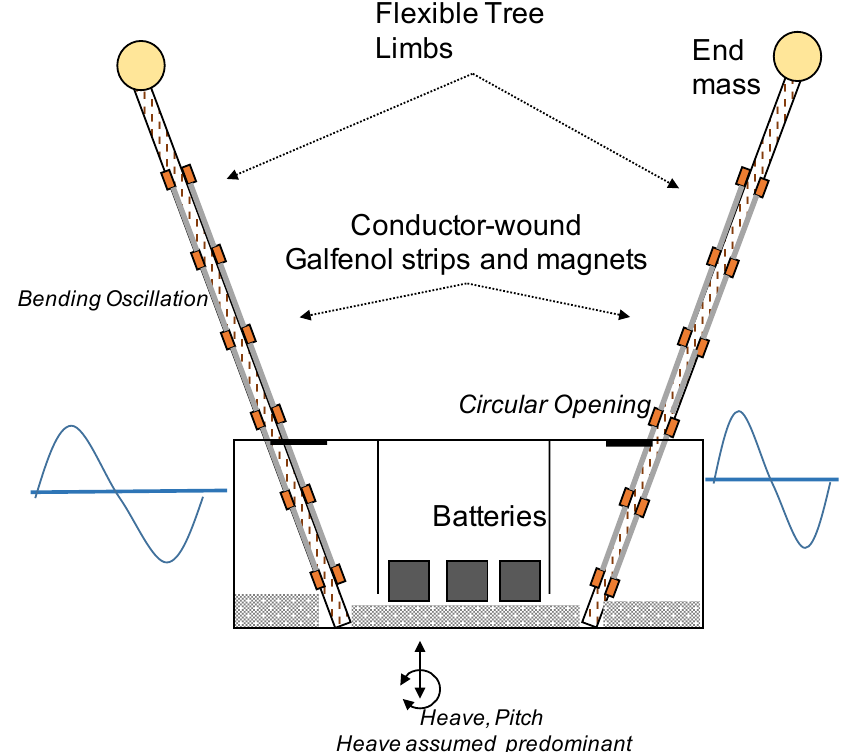
Figure 1. Schematic view of a 2-beam Galfenol power take-off for wave-excited oscillations of a small buoy. Note the significant overhangs for the beams. The boundary conditions used here suitably represent the overhangs. Schematic not to scale. Thanks to Dr. Kevin Baldwin at JHU-APL for generating the machine drawing.